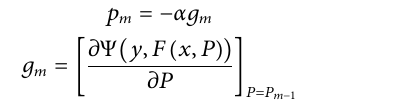
Frontiers in Mechanical Engineering |